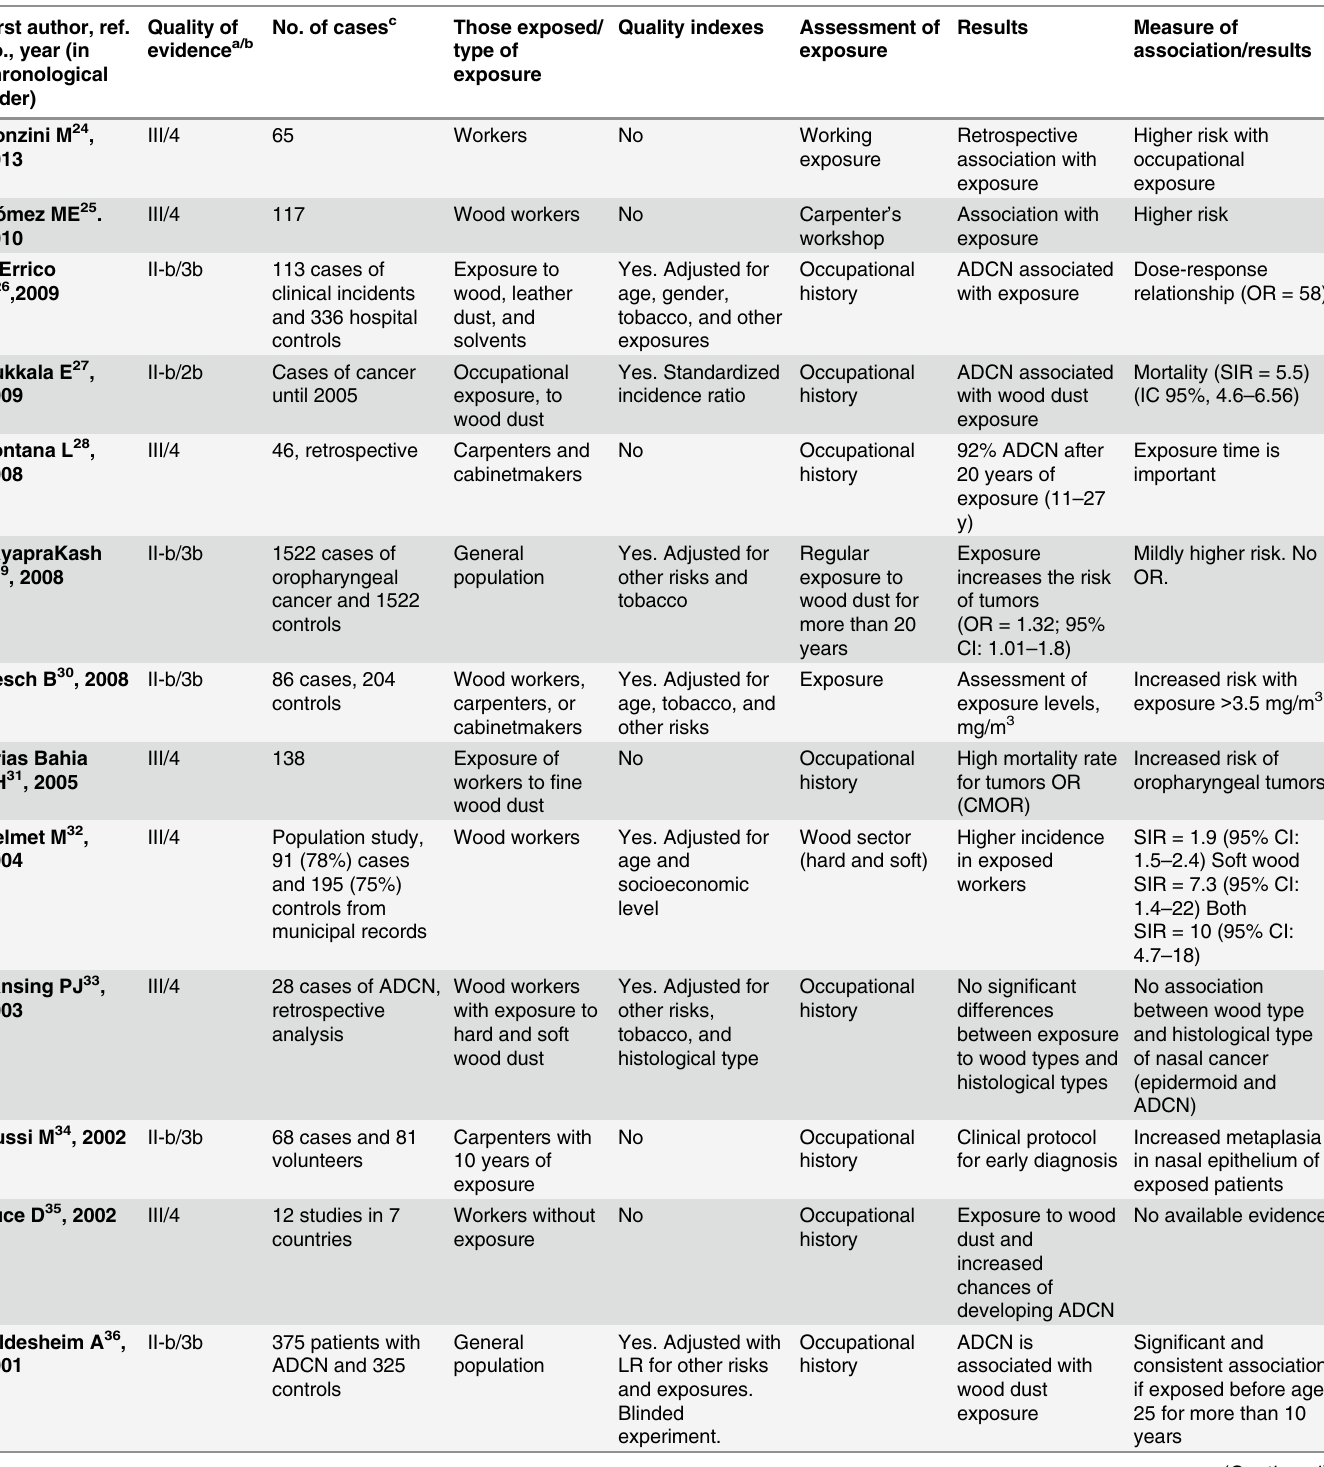
Table 1. Summary of published results on the relation between exposure to wood dust and nasal cancer — adenocarcinoma (ADCN). First author, ref. no., year